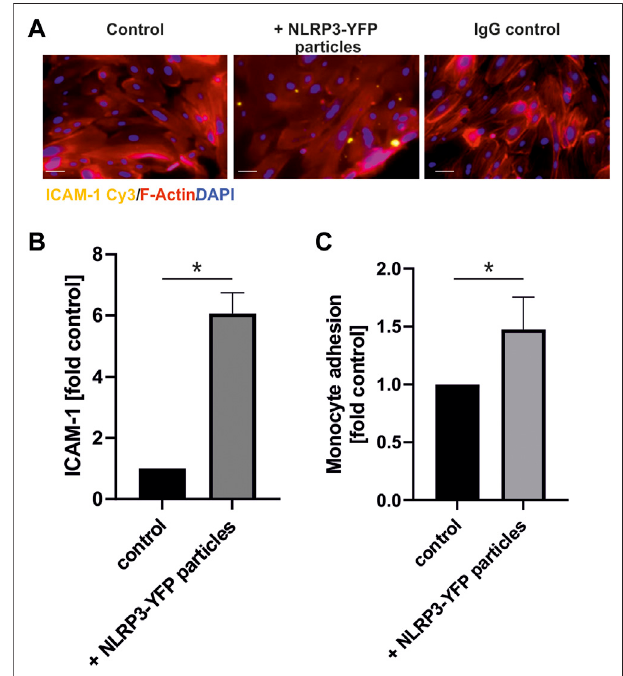
FIGURE5| TreatmentwithextracellularNLRP3 in fl ammasomeparticles induces in fl ammation in endothelial cells. (A) Immuno fl uorescent analysis of ICAM-1 protein expression on coronary artery endothelial cells after 24 h incubation with NLRP3-YFP particles (3 NLRP3-YFP particles/cell) and stained with anti-ICAM1 Cy3 (scale bar: 50 µm). (B) Quantitative analysis of ICAM-1 fl uorescence (N = 4). (C) Calcein-stained THP-1 monocyte adhesion on endothelial cells after incubation with NLRP3-YFP particles for 4 h measured by a fl uorometric analysis and normalized to untreated cells in the culture medium (control). Two-sided unpaired t -test was used to analyze the